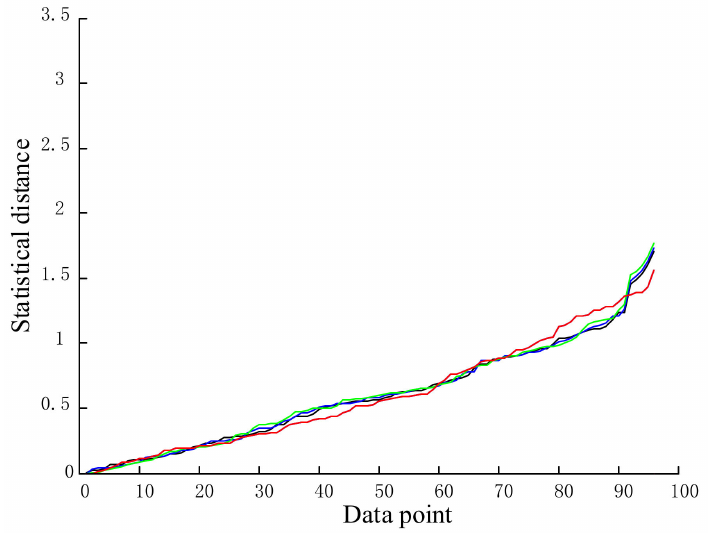
Figure 2. Selected evaluation